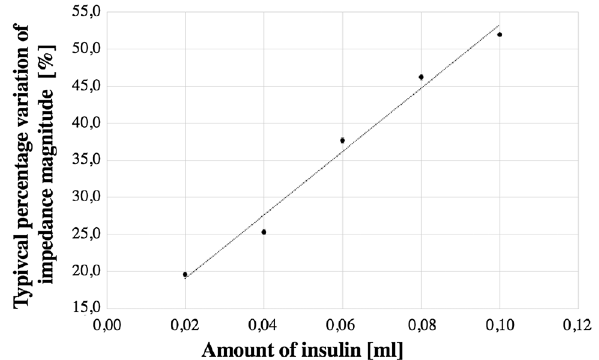
Figure 5. Percentage impedance magnitude variation versus amount of insulin solution in in-vitro experiments in 5 mm setup.